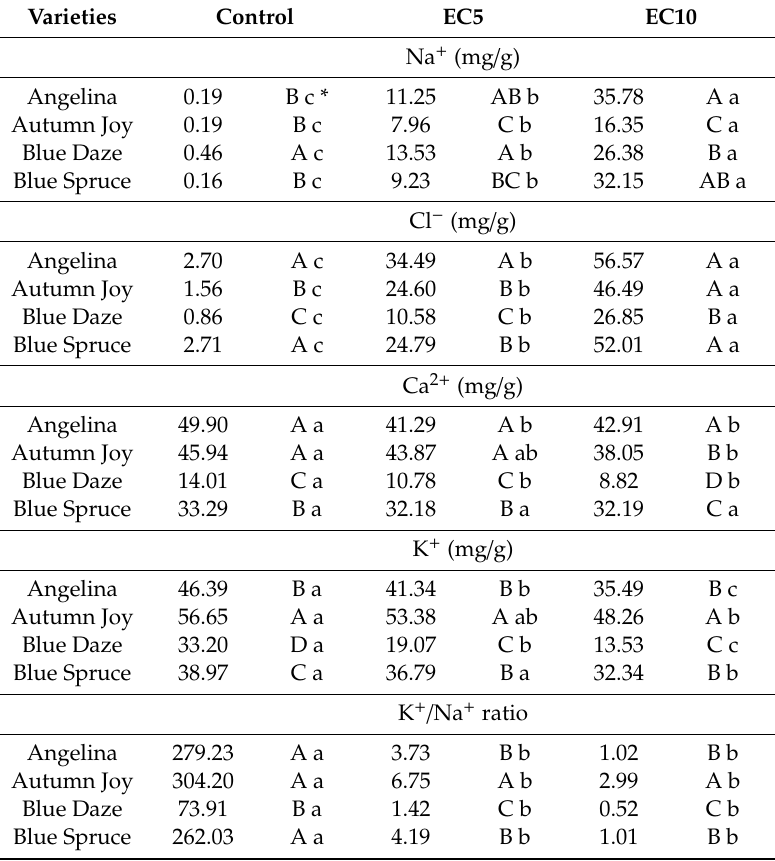
Table 3. Mean concentrations of Na + , Cl − , Ca 2 + , and K + , and the K + / Na + ratio in the shoot tissue of four varieties of perennial ornamentals irrigated with control or saline solutions for eight